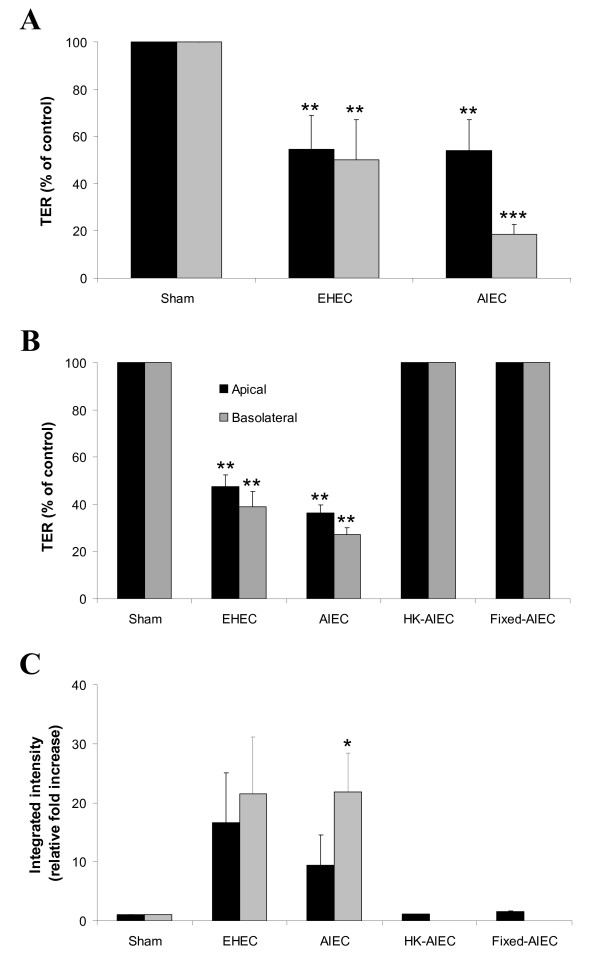
AIEC, strain LF82 disrupts the integrity of polarized epithelial monolayers. Model epithelial cell monolayers [T84 (Panel A) and MDCK-I (Panels B & C)] grown in Transwells were infected with either E. coli, strain LF82 (AIEC) or EHEC O157:H7 – employed as a positive control – for 16 h at 37°C. Both apical (black bar histograms) and basolateral (gray bars) infections of human intestinal T84 monolayers caused a reduction in TER (Panel A; N = 4–6). Similar effects of infection on monolayer integrity were observed when MDCK-I cell monolayers were infected with AIEC, strain LF82 (Panel B), together with an increase in permeability to a macromolecular (10-kilodalton) dextran probe, indicating barrier disruption (Panels C; N = 2–4). HK denotes heat-killed bacteria. ANOVA: * p < 0.05; ** p < 0.01; *** p < 0.001.